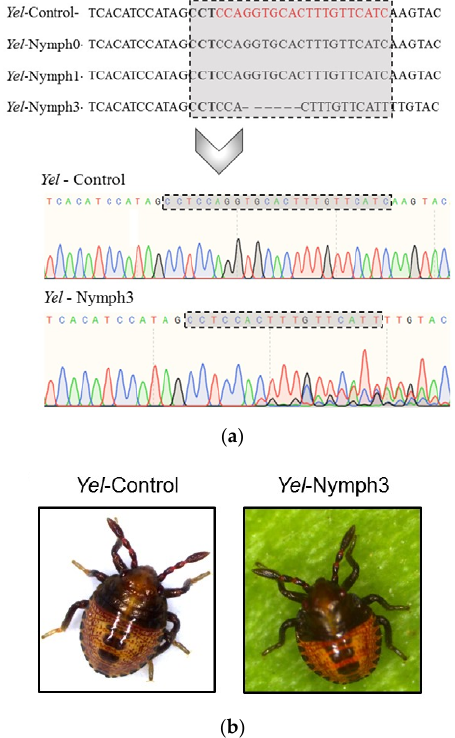
Figure 4. Targeted mutagenesis in the yellow gene ( yel ) of the Brown stink bug, Euschistus heros . ( a ) DNA sequence of the control ( Yel -Control) and test ( Yel -nymph0, Yel -nymph1 and Yel -nymph3) insects. The boxed region highlights the guide RNA (gRNA) sequence (in red for the control) with the bolded triplet “CCT” being the reverse complement of the PAM (protospacer adjacent motif) sequence (NGG). The DNA sequence of Yel -nymph3 presented a mutation with an indel of 6 nucleotides located near the PAM sequence (NGG). This is typical for the Cas9 endonuclease which cleaves the DNA strands at three nucleotides upstream of the PAM sequence, while five nucleotides upstream of the PAM are defined as the seed region for target recognition. For the DNA sequences of nymph0 and nymph1, no mutation was observed. Details of the chromatogram further confirm mutation at the target region in yel . The occurrence of double or multiple peaks in the chromatogram of Yel -nymph3 (in the 3 (cid:48) direction from the gRNA target region) in contrast to the control, indicates mosaicism arising from di ff erent levels of somatic mutations for yel . ( b ) Euschistus heros nymphs (control and nymph3) with no distinct di ff erences in